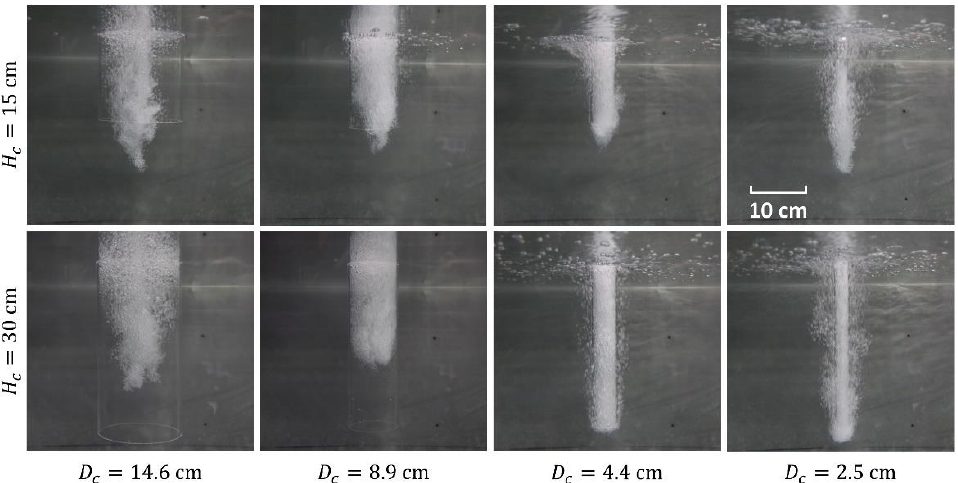
Figure 3. Side view of the bubble plume within the downcomer for experiments with L j = 60 cm and ∆s = 10 psu.